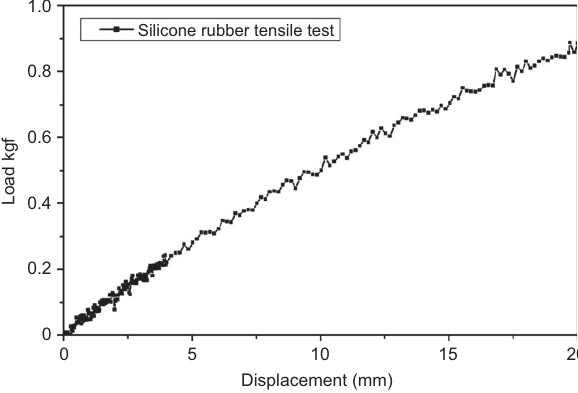
Figure 5 Load-displacement curve of the pure silicone rubber specimen.